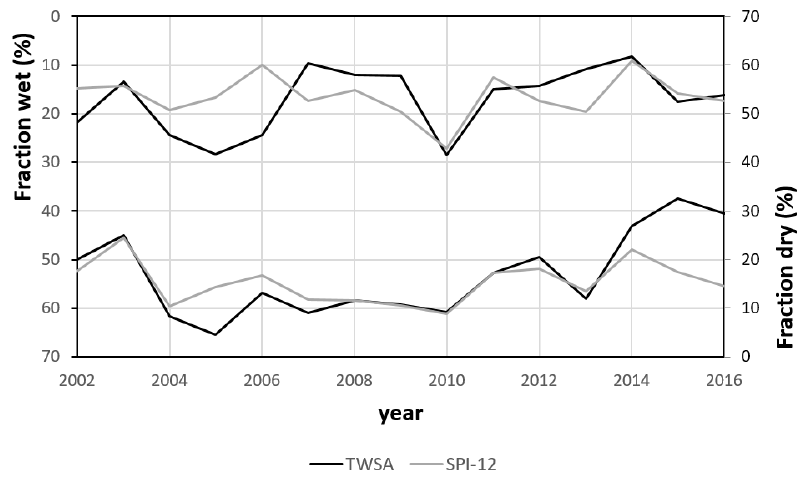
Figure 8. Time series of the year-average percentage of dry (on the right-side axis) and wet (on the left-side axis, inverted) cells over Europe according to TWSA (black line) and SPI-12 (grey line).